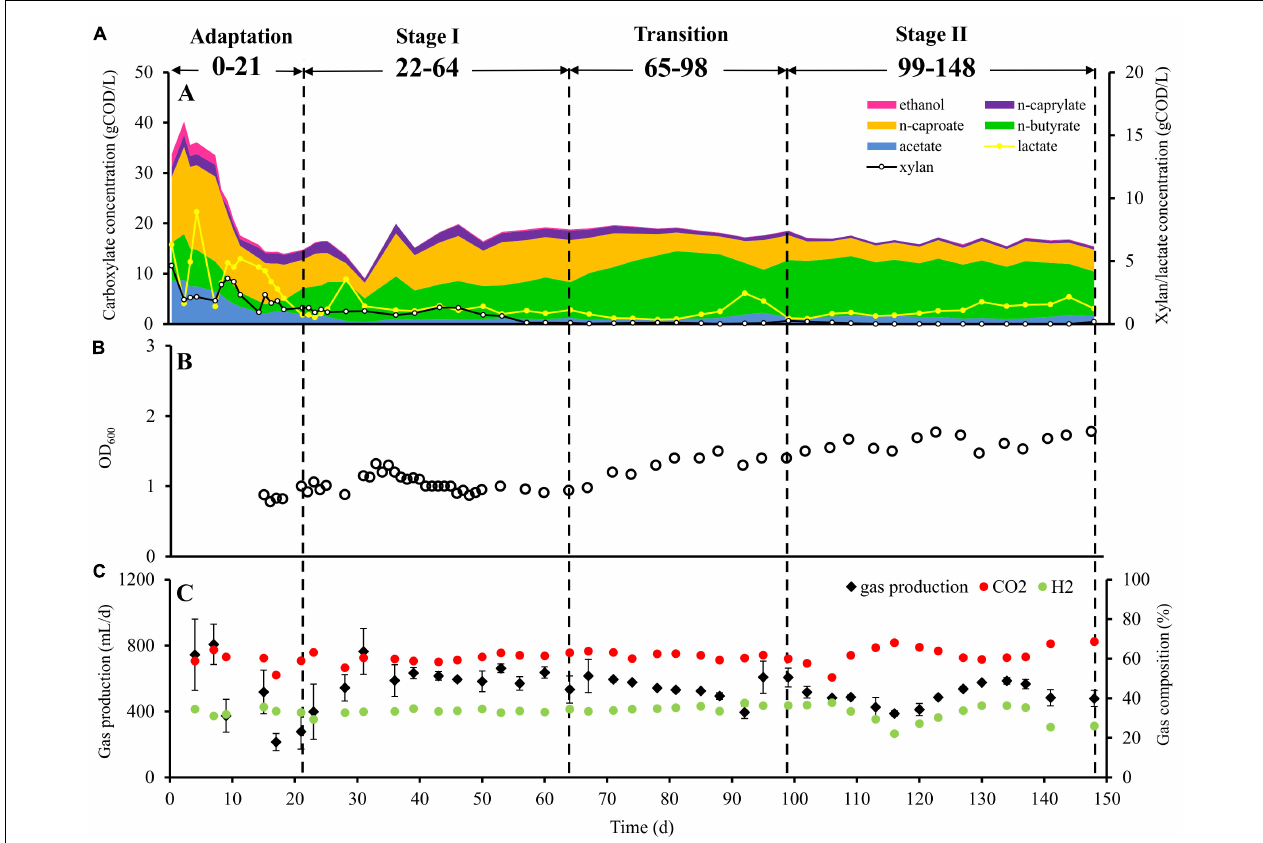
FIGURE 1 | Performance of bioreactor. (A) Substrate and product concentrations in the bioreactor during the four succession stages, (B) cell concentration (OD 600 value) in the bioreactor during the four succession stages, and (C) daily gas production and gas composition during the four succession stages. Data points for gas production indicate mean values of 3 days. Within 95% confidence intervals, the error bars represent the standard